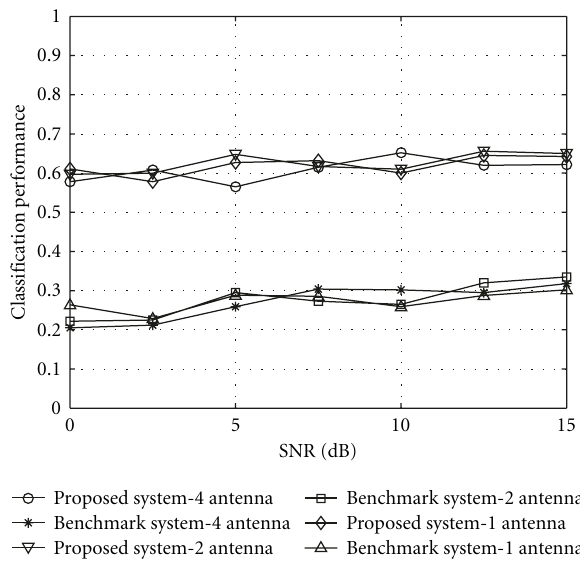
Figure 17: Ability of proposed classifier and benchmark to determine a signal’s modulation family in a slow 20-path fading channel using